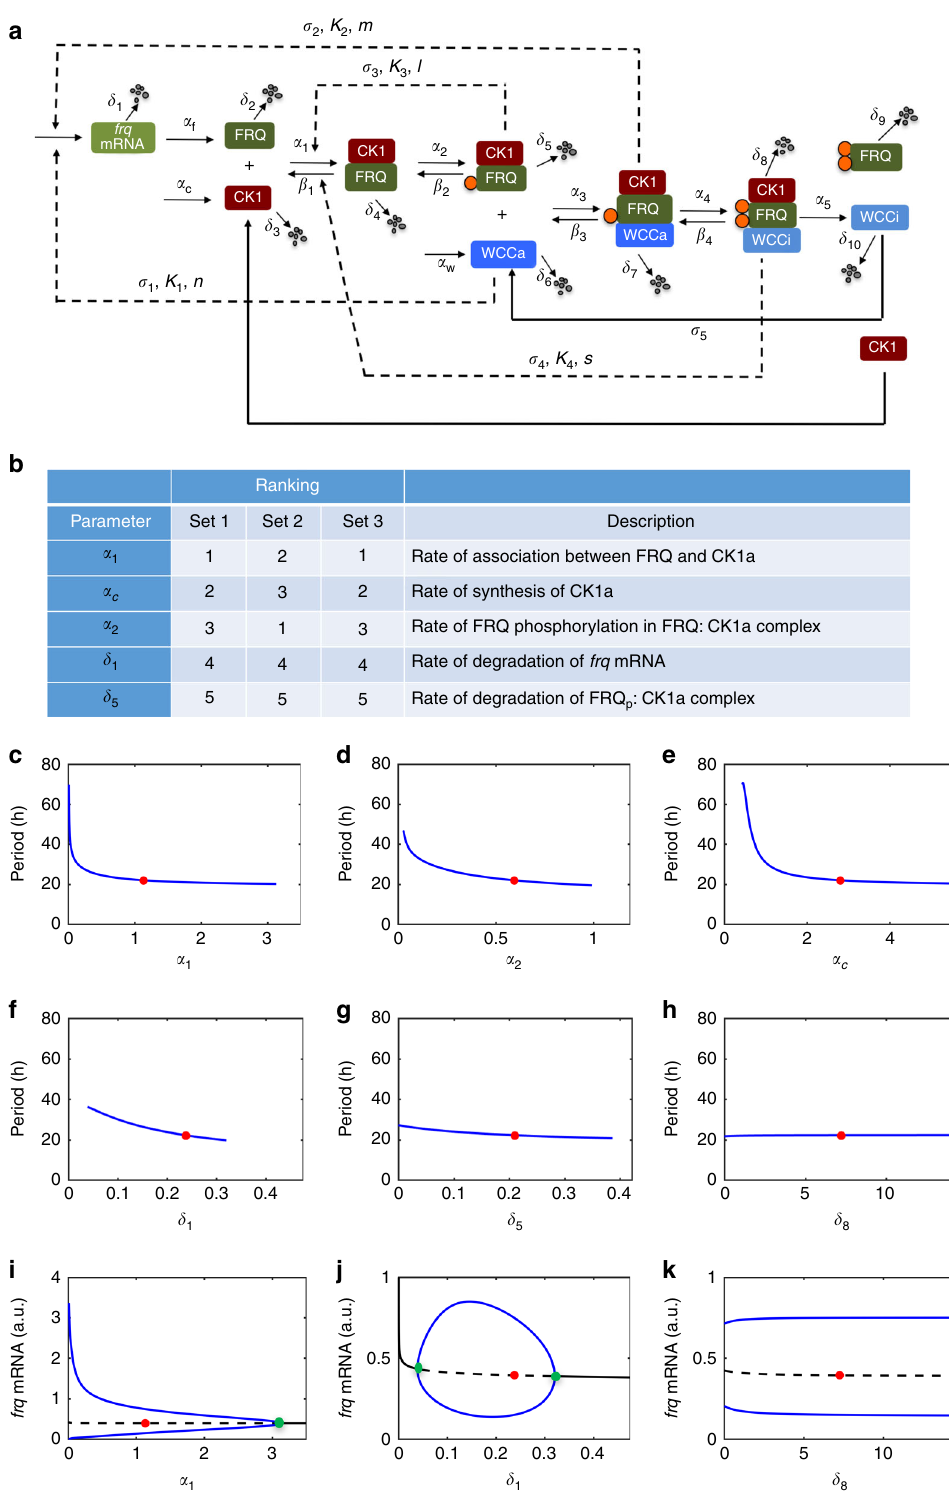
Fig. 5 Mathematical modeling of circadian period determination. a Wiring diagram for the Neurospora circadian clock. Dashed arrows indicate modes of action of proteins or protein complexes, and the letters above each arrow indicate parameters involved in the step. Solid orange circles indicate phosphorylation of FRQ by CK1a. Please see the methods and supplementary information for equations and description of parameters. b The top fi ve parameters that in fl uence the period of the Neurospora circadian clock identi fi ed from computer simulations using three independent sets of parameters. c – h Representative changes of period as a function of α 1 , α 2 , α c , δ 1 , δ 5 , and δ 8 from the parameter set 1. Solid red circles indicate default parameter values. i – k One-parameter bifurcation diagrams as functions of α 1 , δ 1 , and δ 8 indicating the steady state of frq mRNA. Solid black lines represent stable steady state and dashed black lines represent unstable steady state with stable limit cycle. Blue lines indicate maximum/peak and minimum/trough of frq mRNA oscillations. Solid red circles indicate default parameter values, and solid green circles indicate Hopf bifurcation